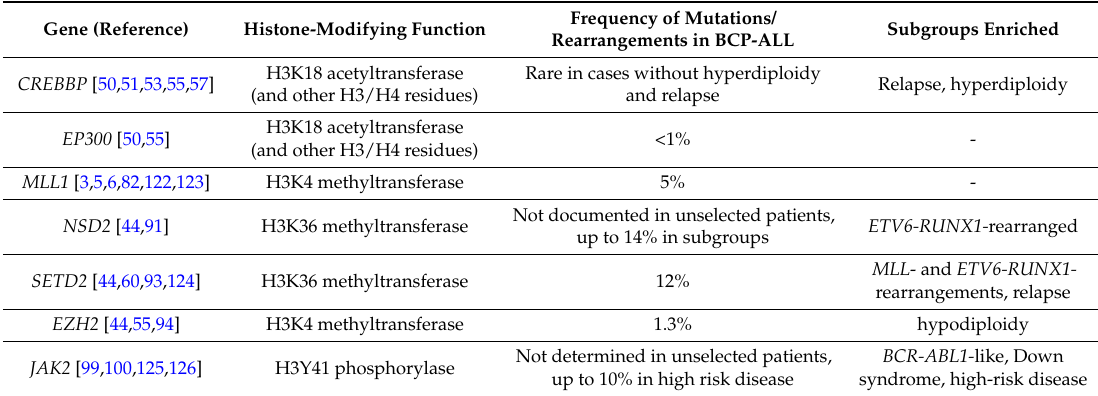
Table 1. Mutations/rearrangements of histone writers and erasers in B-cell progenitor acute lymphoblastic leukemia (BCP-ALL).